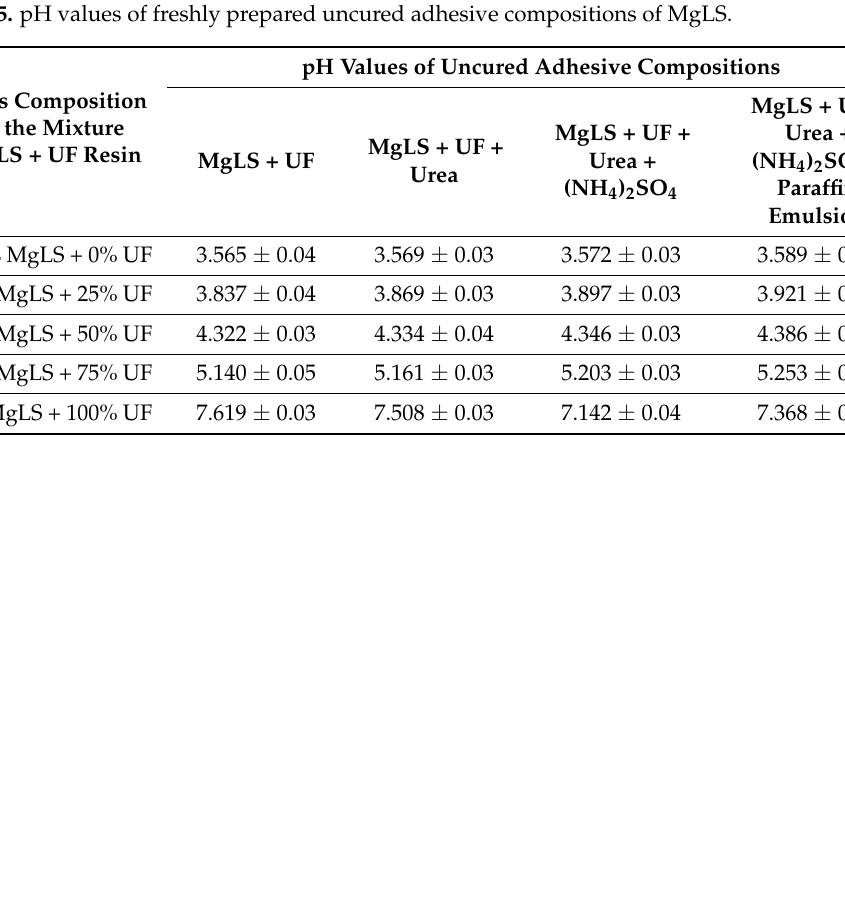
Table 5. pH values of freshly prepared uncured adhesive compositions of